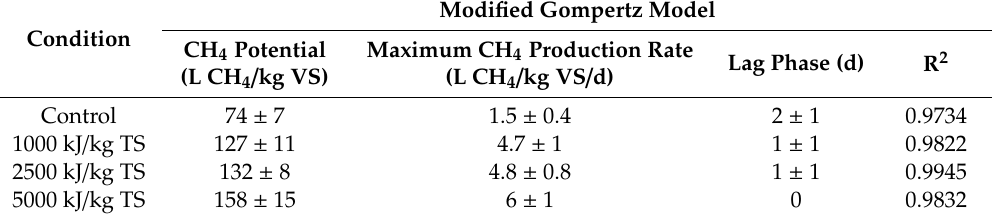
Table 1. Kinetic parameters estimated with biochemical methane potential (BMP) test data fitting. TS: total solids.